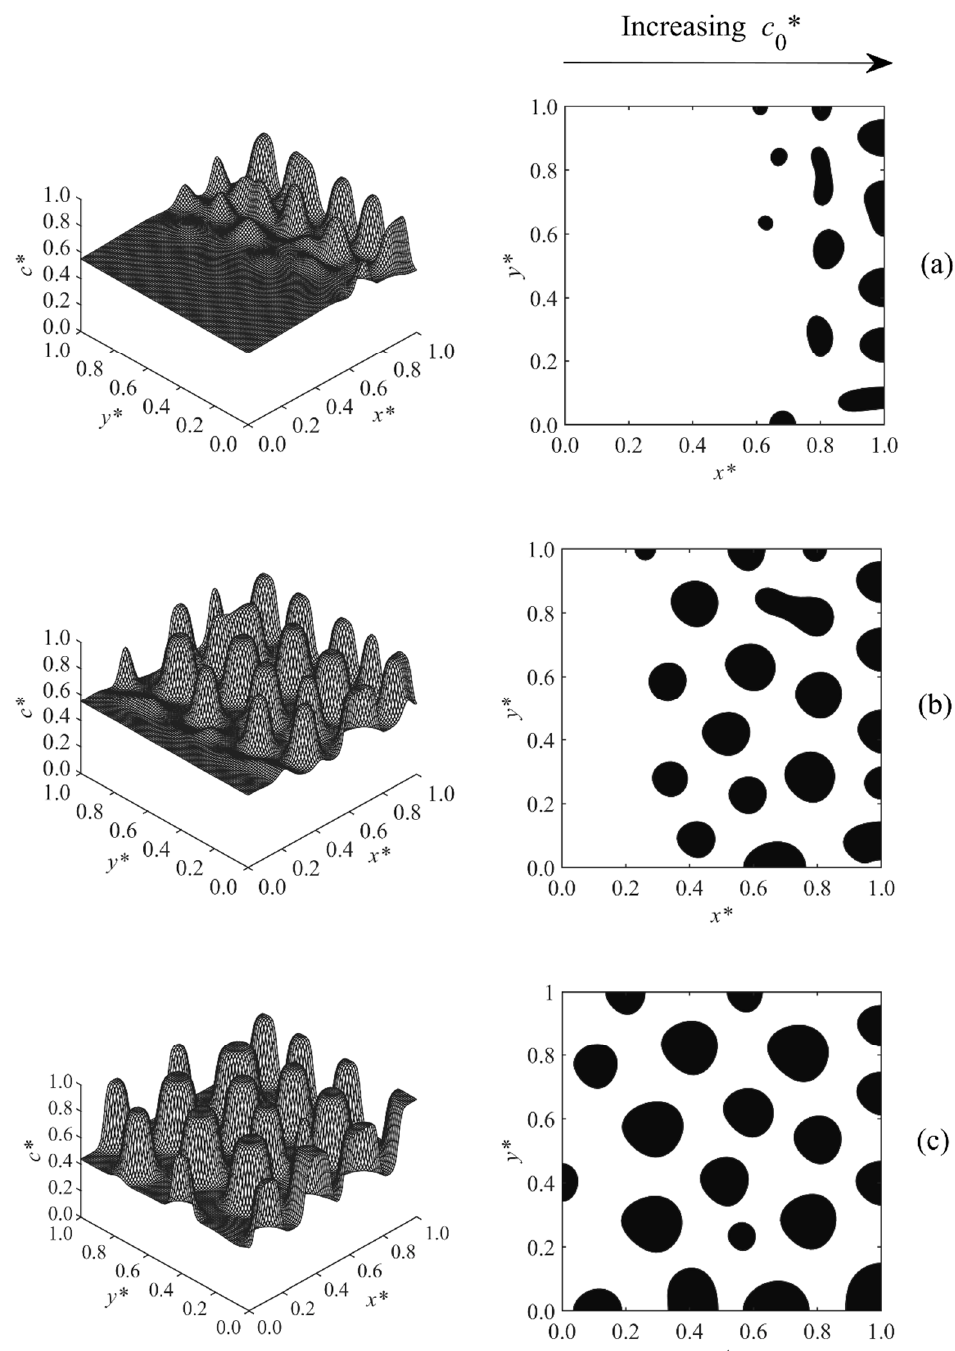
Figure 2. Spatial concentration profiles (first column) and phase-separated patterns (second column) for Case 1 at the following times: ( a ) t ∗ = 2.14 × 10 − 4 , ( b ) t ∗ = 2.18 × 10 − 4 , and ( c ) t ∗ = 2.24 × 10 − 4